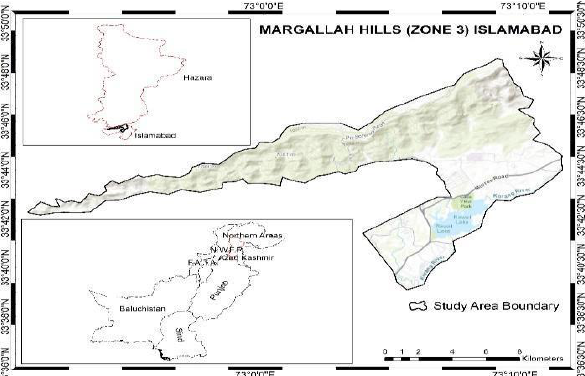
Figure 1: Study Area Margalla Hills National Park (MHNP) Islamabad,